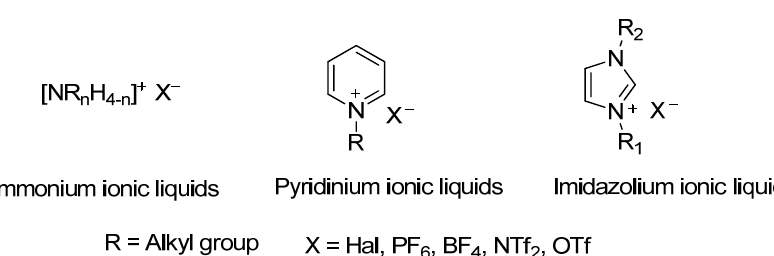
Figure 1. The three main types of ionic liquids